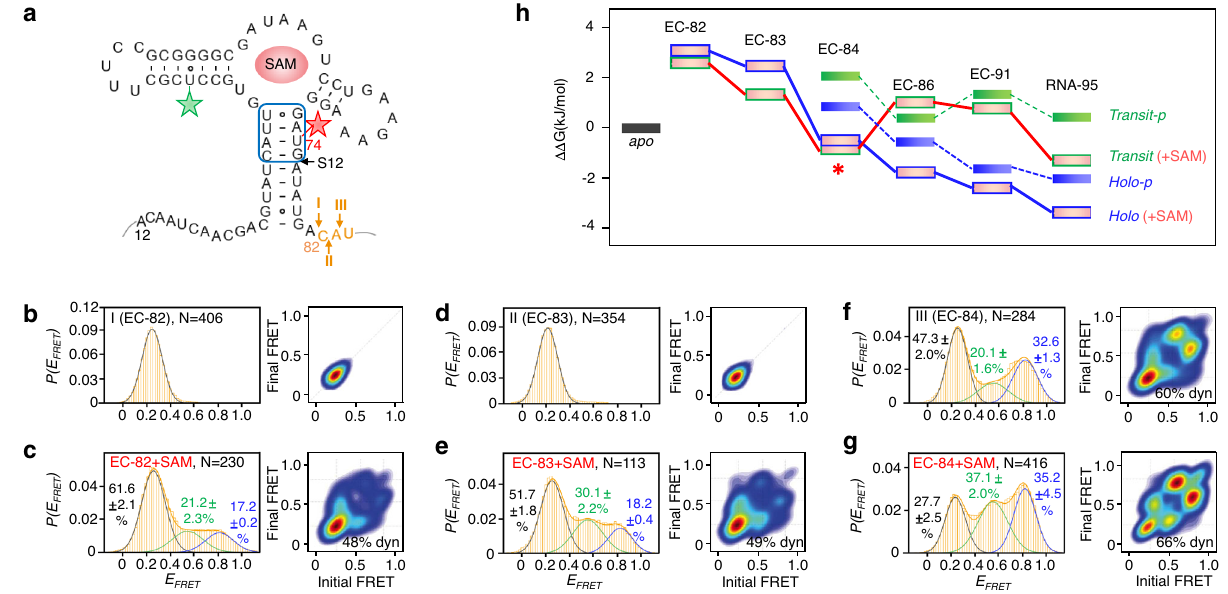
Fig. 4 | smFRET studies of nascent riboSAM in ECs with and without SAM at single-nucleotide resolution. a The transcription of nucleotides in orange was dividedinto three steps(I,II, and III), inwhichonly onenucleotide was transcribed per step and generated EC-82, EC-83, and EC-84 used for smFRET measurements. TheCy3-Cy5FRETpair(greenandredstars)waslabeledatsites37and74.Thebase pairs of P 1 helix formed in EC-82 at step I are boxed. b – g smFRET histograms and transition density plots for EC-82 at 0 and 0.5mM SAM ( b and c ), EC-83 at 0 and 0.5mM SAM ( d and e ), and EC-84 at 0 and 0.5mM SAM ( f and g ). The Mg 2+